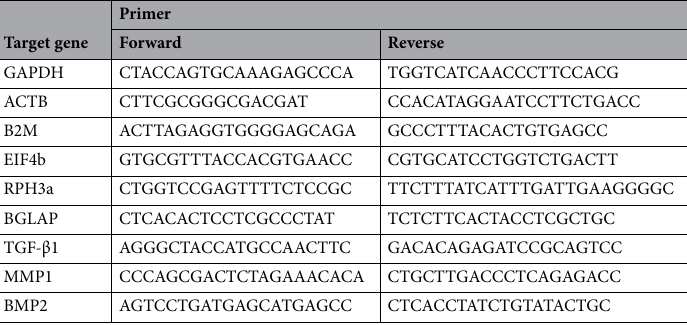
Table 1. List of primer sequences used in this